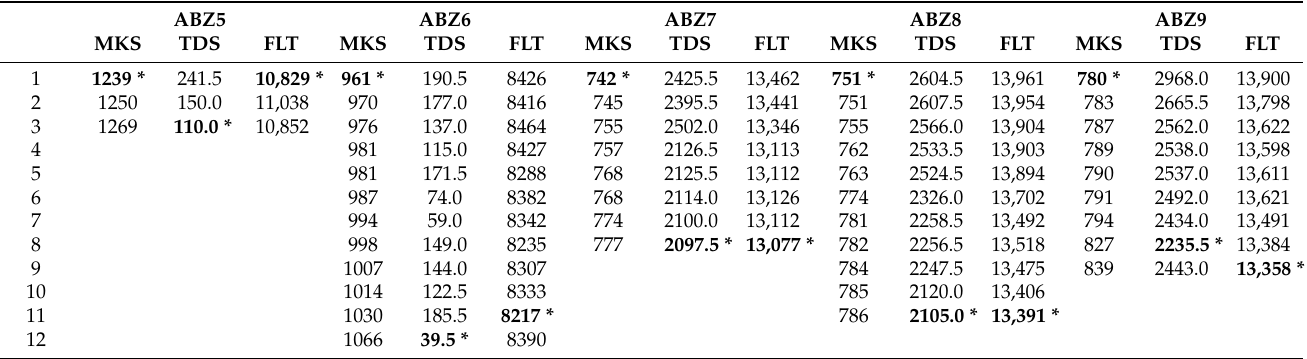
Table A18. Non-dominated solutions obtained by SS/CMOTA for the JSSP instances proposed by [39].